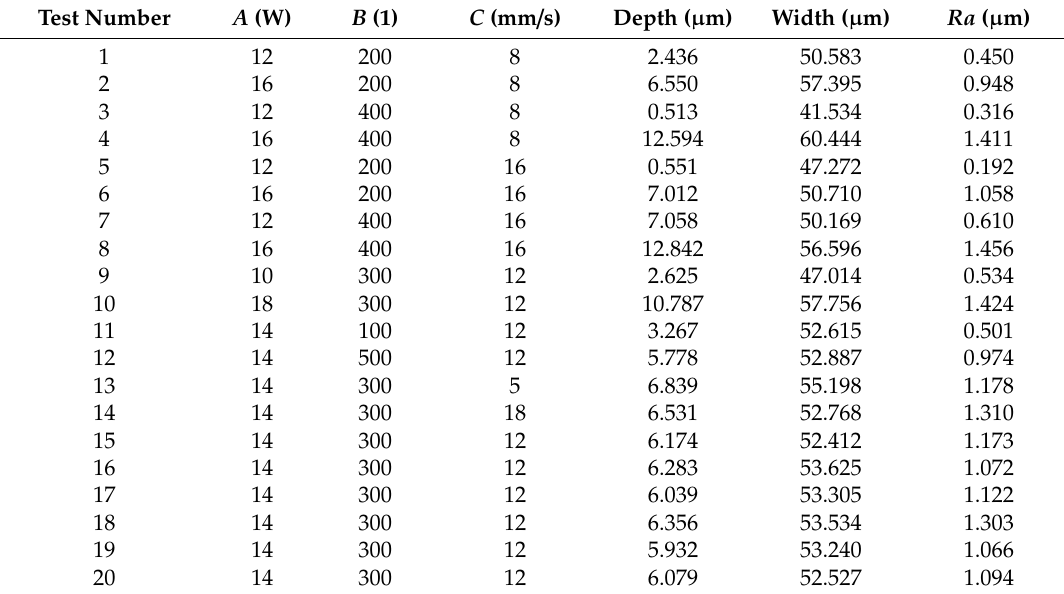
Table 2. Experimental results of the multiobjective